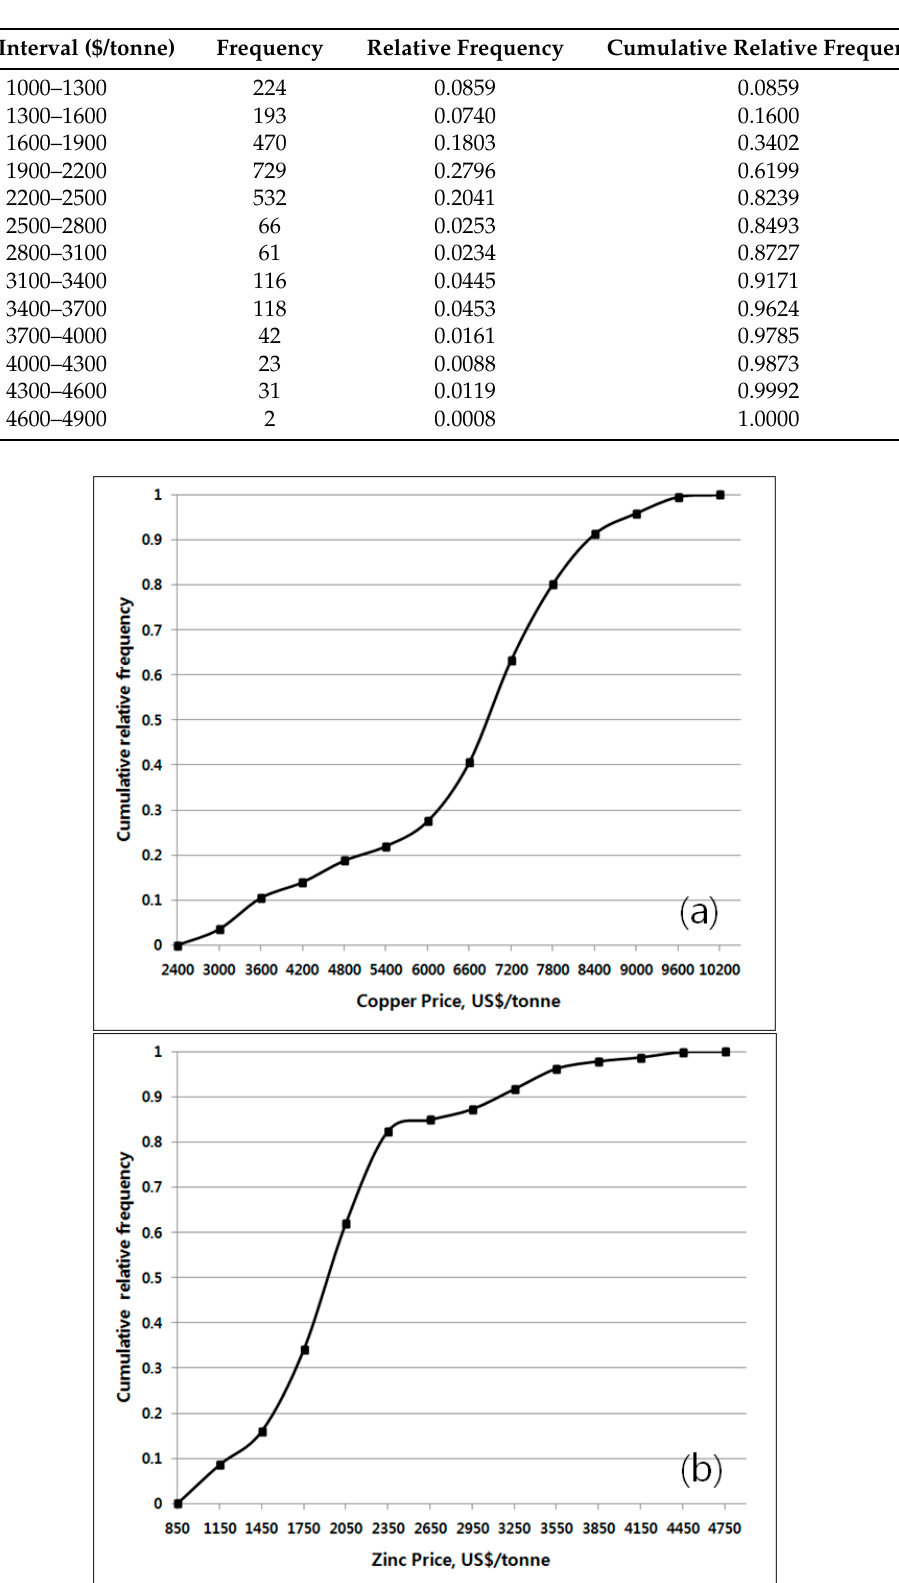
Table 2. Cumulative relative frequency of zinc prices.